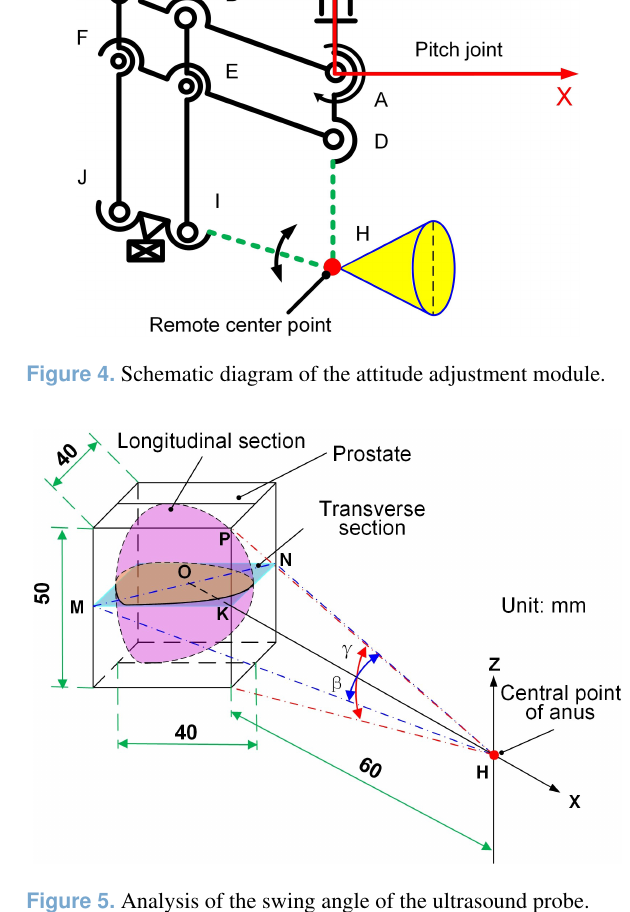
Figure 5. Analysis of the swing angle of the ultrasound